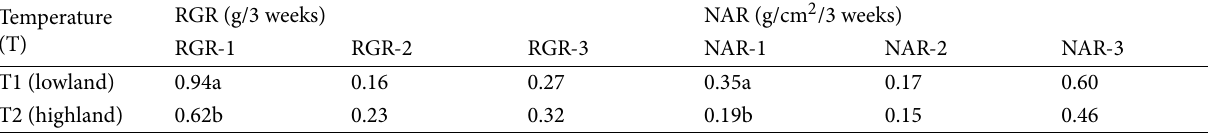
Table 3 Differences in selected physiological parameters caused by temperature at 4, 7, 10, 13 weeks after